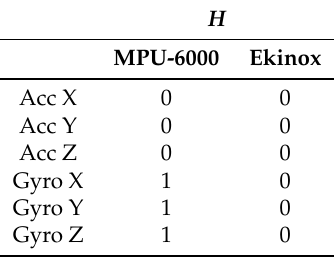
Table 3. Normality test based on Anderson-Darling procedure for every inertial sensor from Ekinox and MPU-6000 IMUs. The result H is 1 if the test rejects the null hypothesis at the 5% significance level, and 0